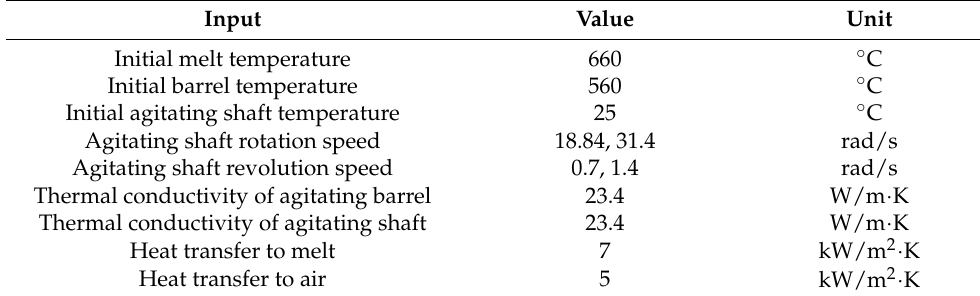
Table 1. Process and initial conditions of the simulation.